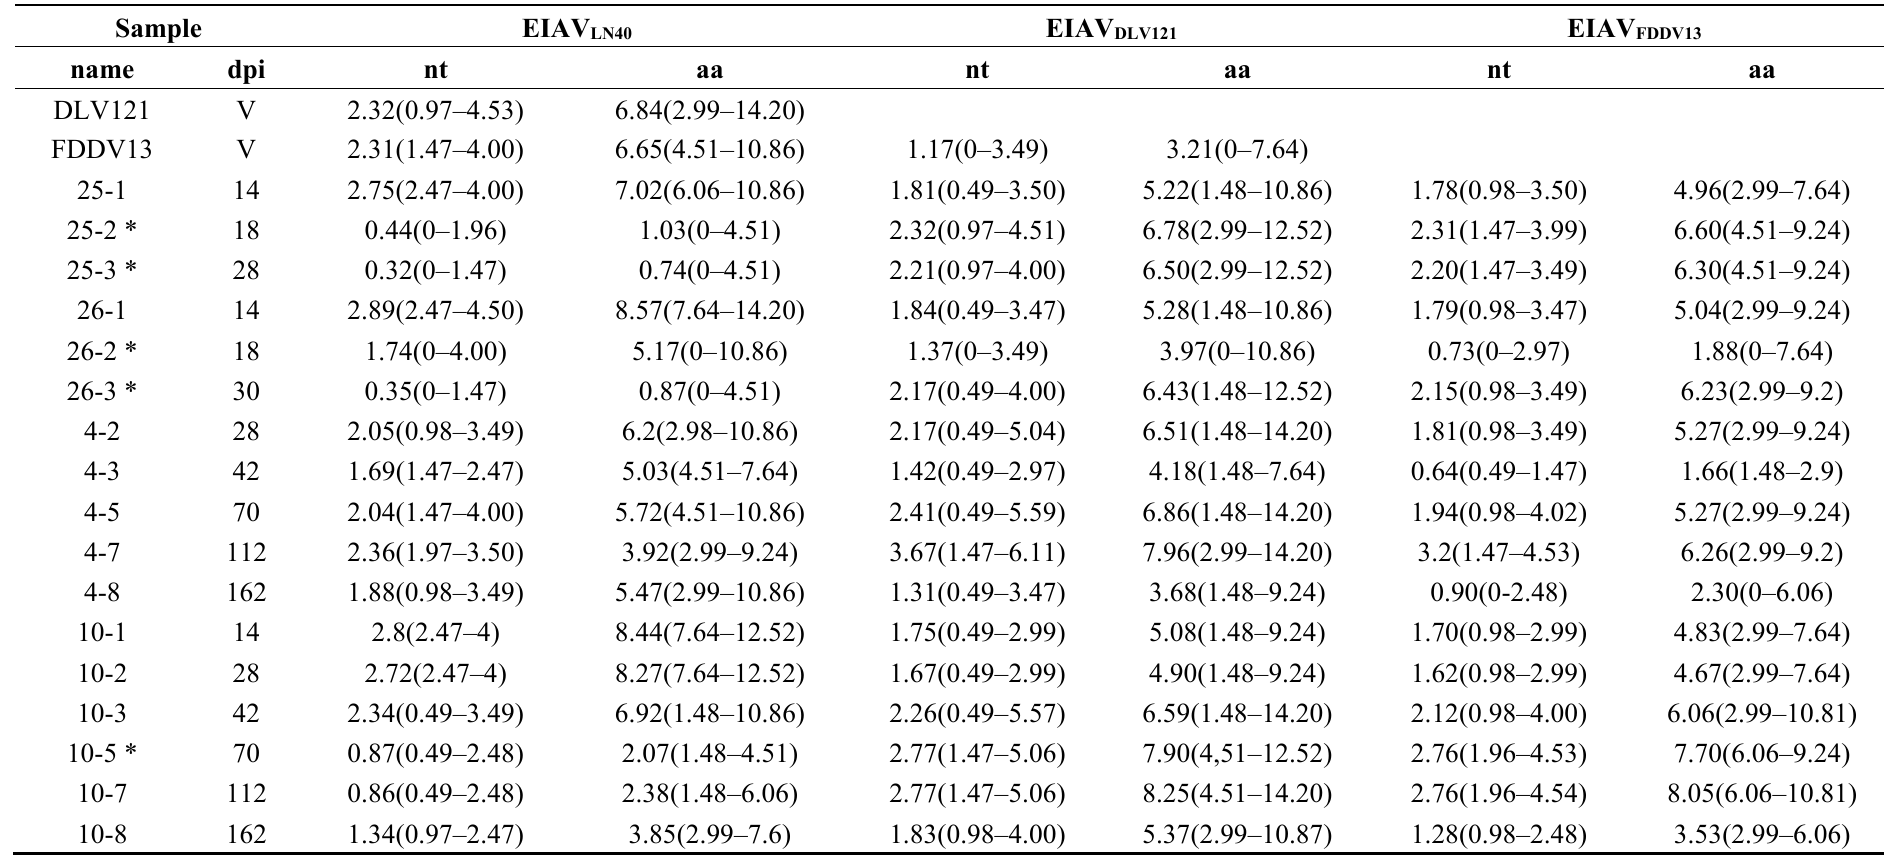
Table 1. Comparison of nucleotide and amino acid genetic distances of the S2 genes of viruses isolated from different samples infected with EIAV LN40 and the vaccine strains EIAV DLV121 and EIAV FDDV13 . Sample EIAV